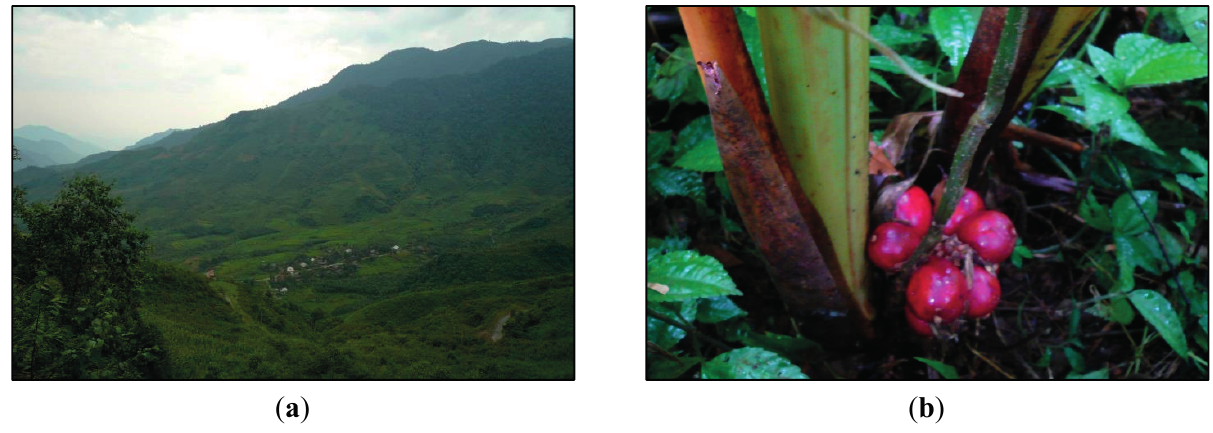
Figure 7 . ( a ) Forest containing cardamom fields above a Hmong hamlet and ( b ) cardamom growing in the shade of mature trees Bát Xát District, Lao Cai Province. (Photo credit: Sarah